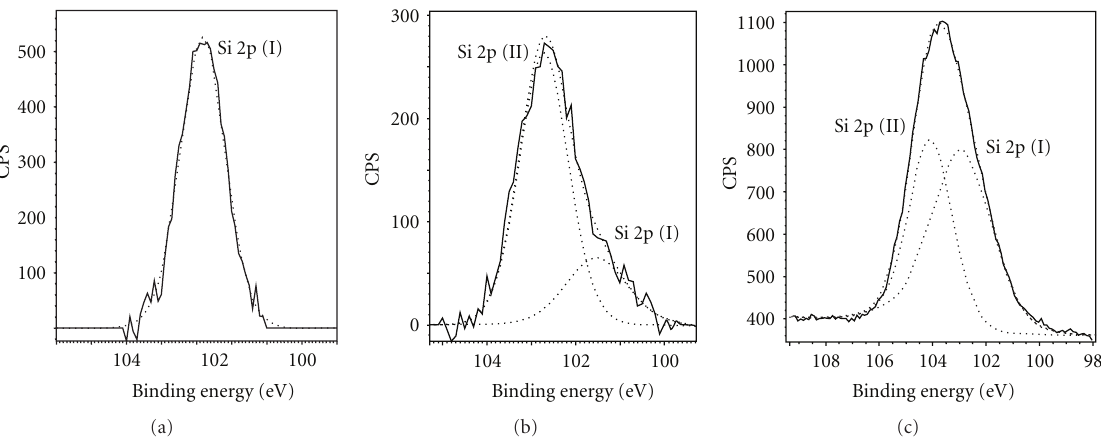
Figure 3: High-resolution XPS spectra of Si 2p levels for (a) OTS, (b) Hexa, and (c) MPdS samples.